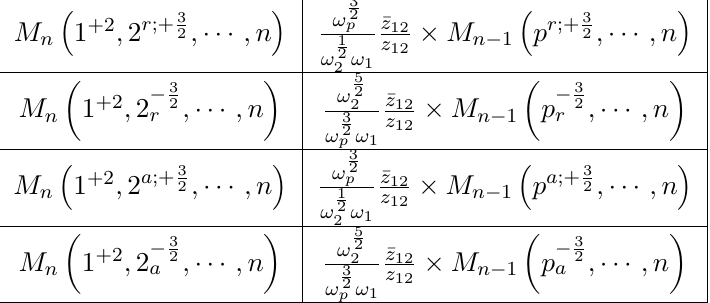
Table 9 . Amplitude corresponding to collinear graviton and gravitino.